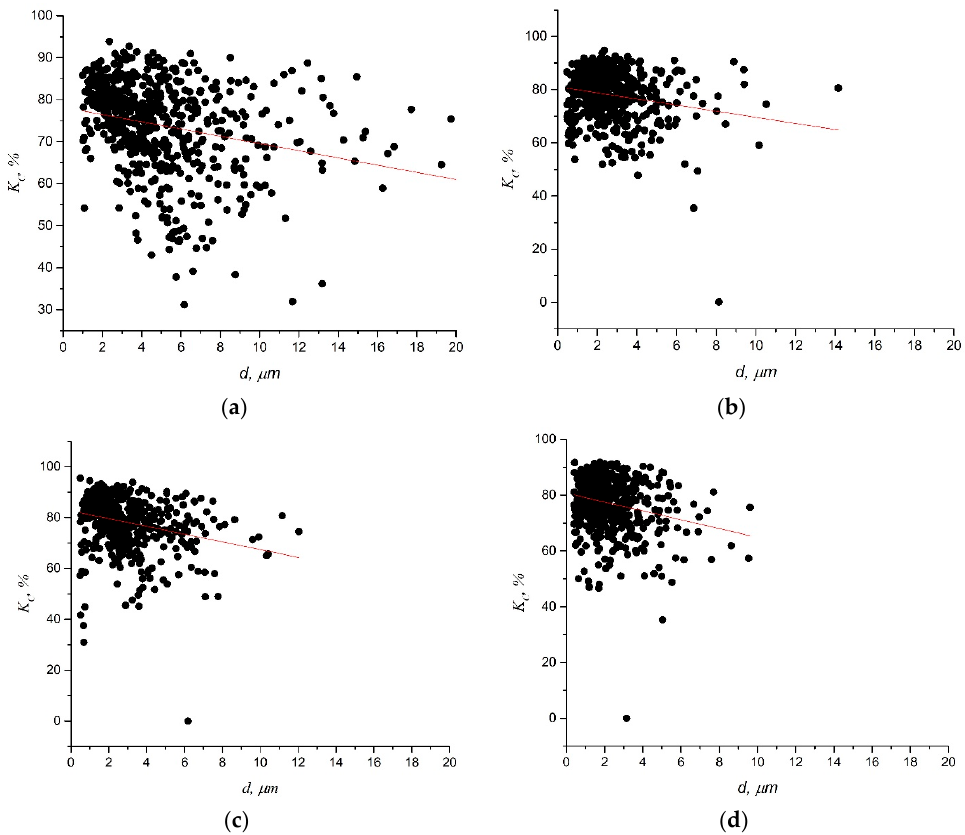
Figure 6. Dependence of the dimple shape parameter K c on its equivalent diameter d for alloys VT23 ( а ) and VT23M ( b – d ) under static ( а , b ) and impact ( с , d ) loading.